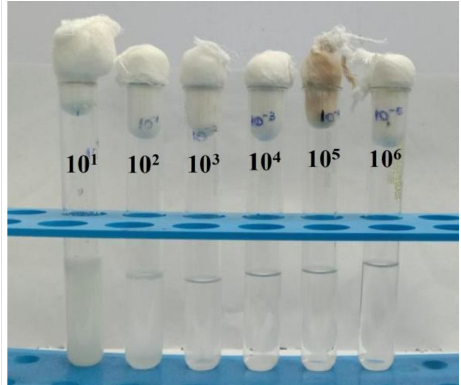
Figure 15. Milk samples (cow and buffalo milk) serially diluted ranging from 10 − 1 –10 − 6